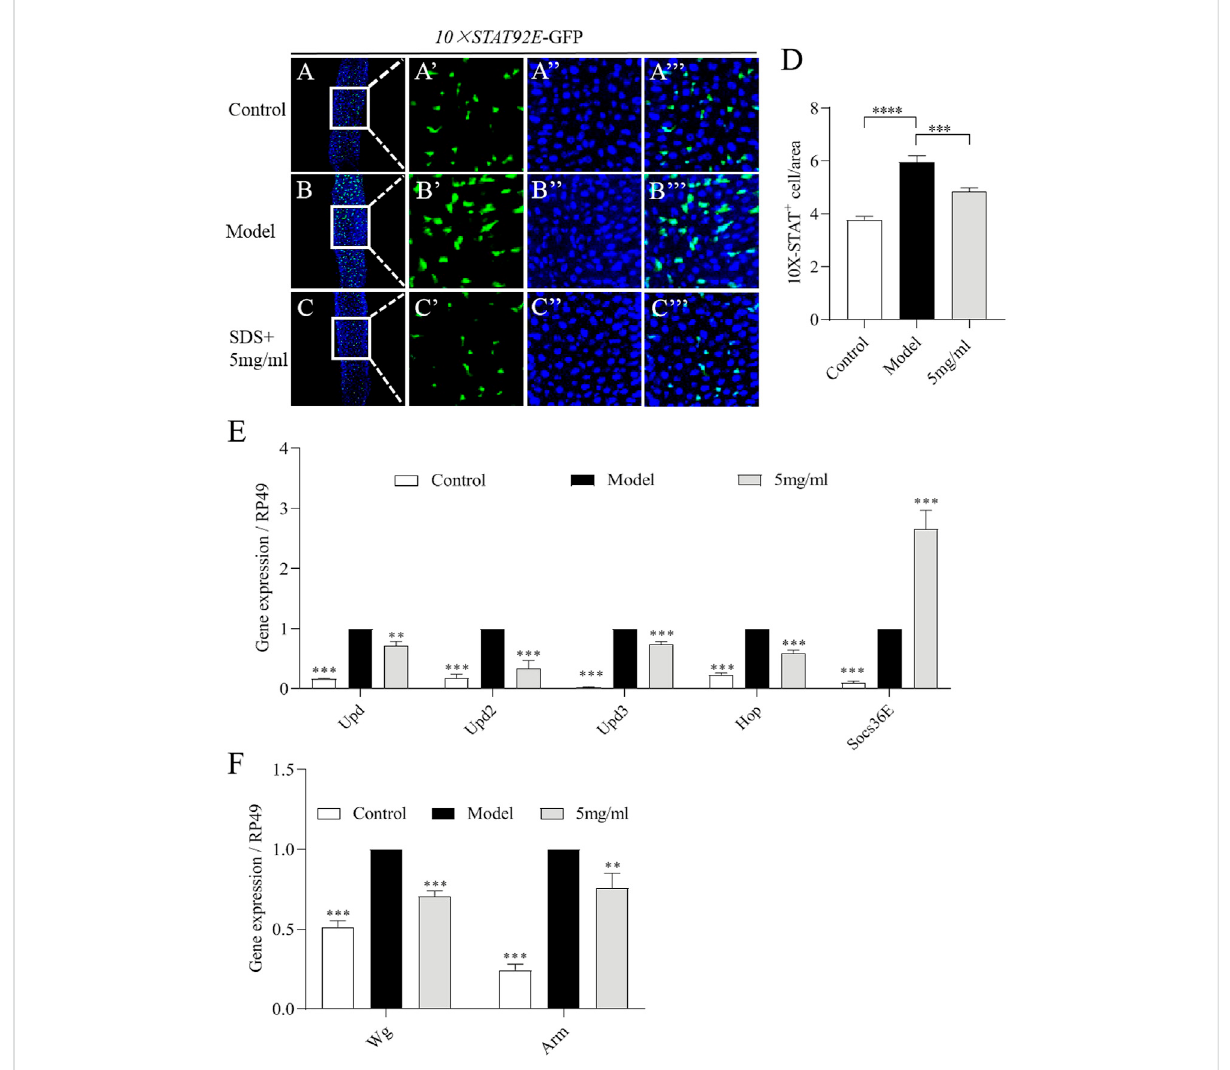
FIGURE 7 FPErestrainsJAK-STATsignalingandWntsignalingpathwaysinSDS-stimulatedgut. (A – C) Immunostainingofadultfemaleposteriormidgutsin 10×STAT92E- GFP fl ies after 16 h treatment with or without 0.6% SDS. GFP staining highlighted 10×STAT92E- GFP expression (green). (D) Quanti fi cation of the numbers of 10×STAT92E positive cells in the midguts ( n = 29). (E) mRNA levels of Upds ( Upd , Upd2 and Upd3 ) and JAK-STAT pathway ( Hop and Socs36E ) from midgut in control fl ies and 0.6% SDS stimulated fl ies fed with or without 5 mg/ml FPE ( n = 3). (F) mRNA levels of Wnt signaling ( Wg and Arm ) in the gut ( n = 3).* p < 0 0.05, ** p < 0.01, *** p < 0.001 vs. the model group (SDS- stimulated